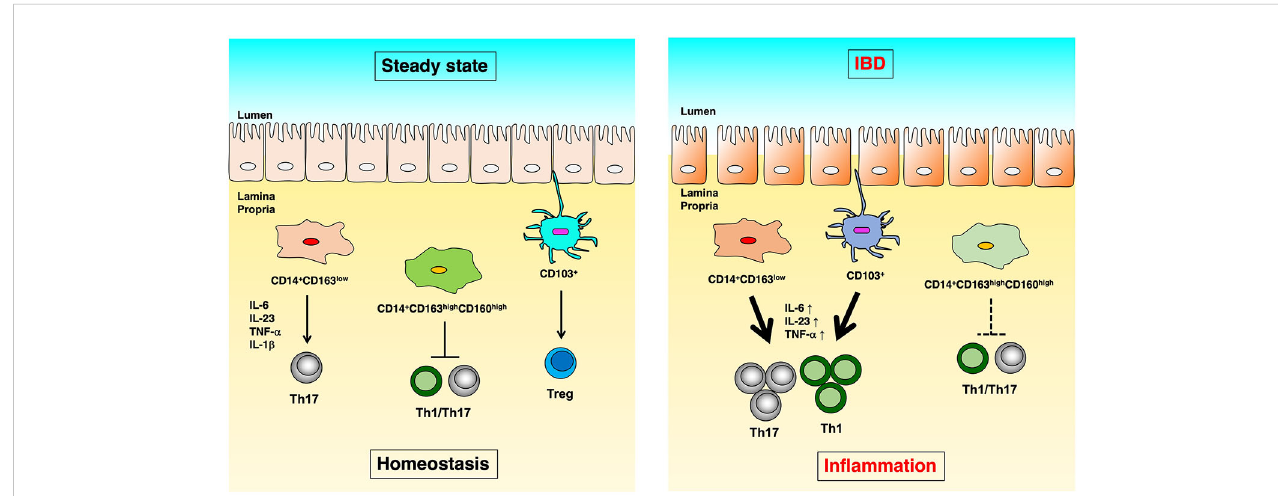
FIGURE 1 The difference of immunoregulation between steady state and IBD. In human intestinal lamina propria, CD14+CD163low cells induce Th17 differentiation in an IL-6, IL-23p19, TNF- a , and IL-1 b dependent manner. CD14+CD163highCD160high cells suppress the proliferation of CD4+ T cells. CD103+ dendritic cells induce Treg cells in steady-state (left). On the other hand, in Crohn ’ s disease, CD14+CD163low cells have signi fi cantly increased expression of IL-6, IL-23p19, and TNF- a , as well as enhanced Th17 induction capacity. In ulcerative colitis, CD14+CD163highCD160high cells reduce the ability to suppress CD4+ T cell proliferation, and CD103+ dendritic cells showed reduced Treg- and enhanced Th17-inducing capacity